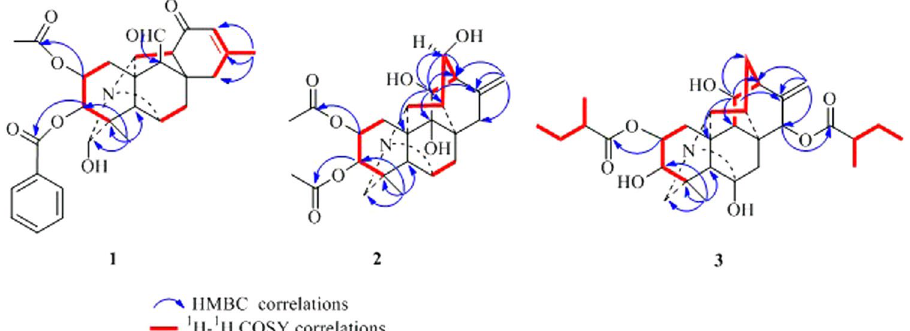
Figure 2. Key HMBC and 1 H– 1 H COSY interactions of compounds 1 – 3